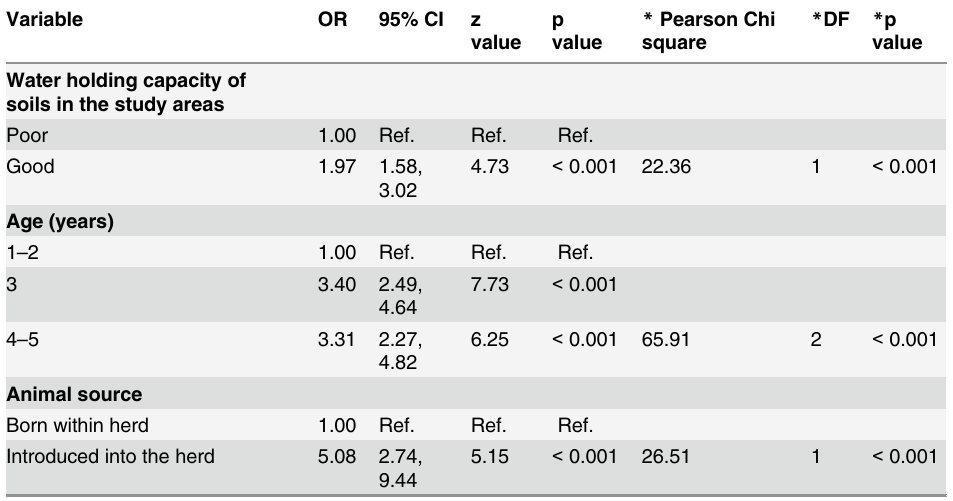
Table 4. Risk factors for RVFV seropositivity in Tanzania included in final multivariable mixed effects logistic regression model (herd was included as random effect variable).